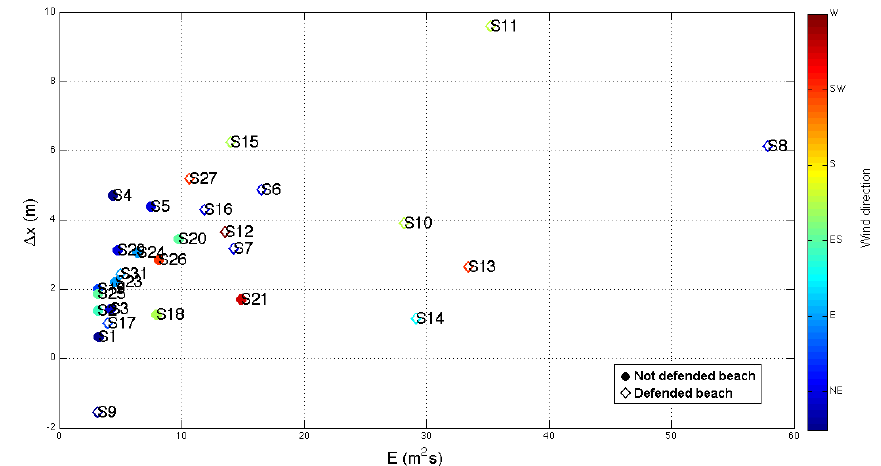
Figure 13. Relationship between wave energy and shoreline